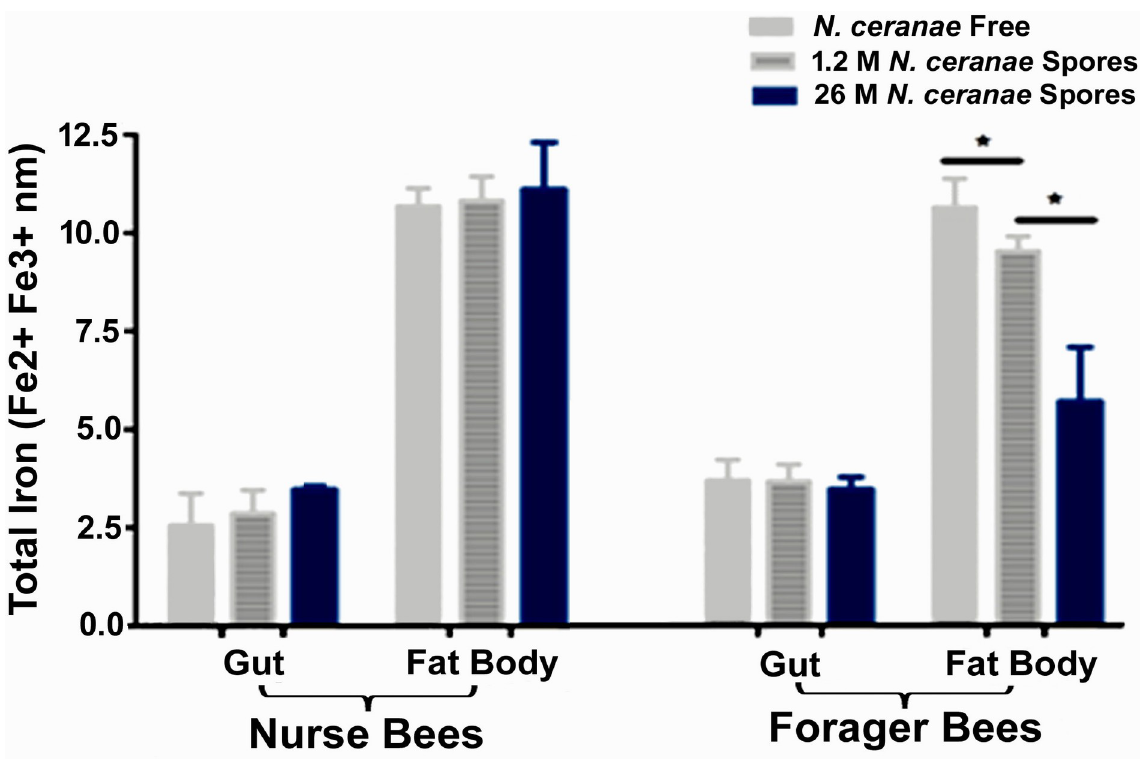
Fig 4. Tissue specific total amount of iron in gut and fat body tissues of nurse and forager bees. An asterisk ( � ) denotes a statistically significant difference between the two groups (p � 0.05).